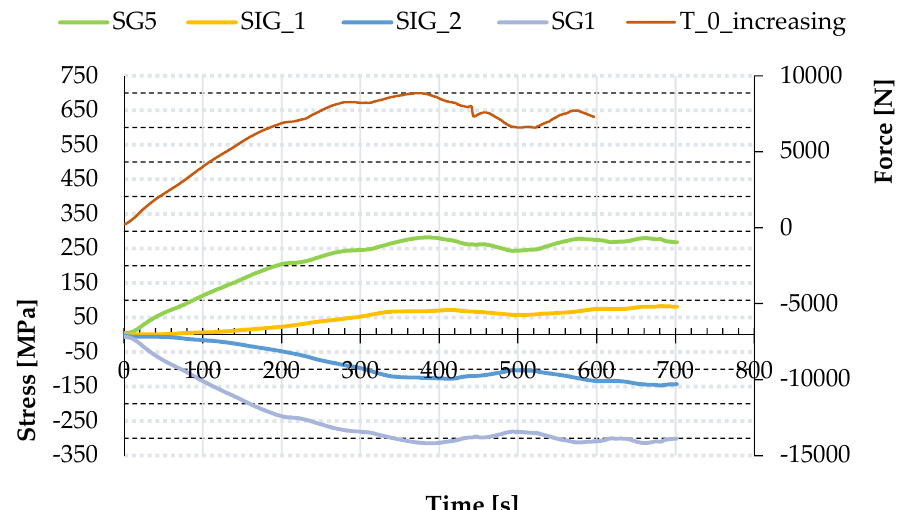
Figure 7. Force–time and stress–time paths obtained in experimental tests for increasing loading.